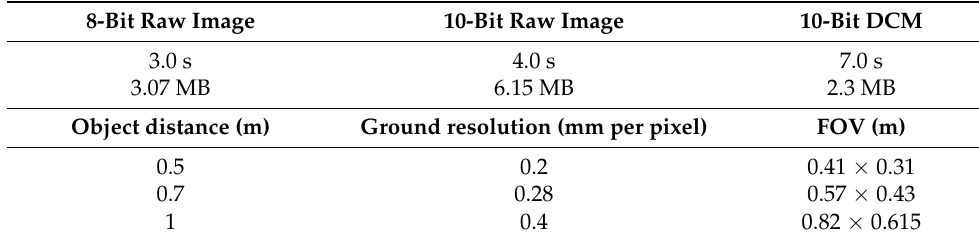
Table 1. Sampling rates and